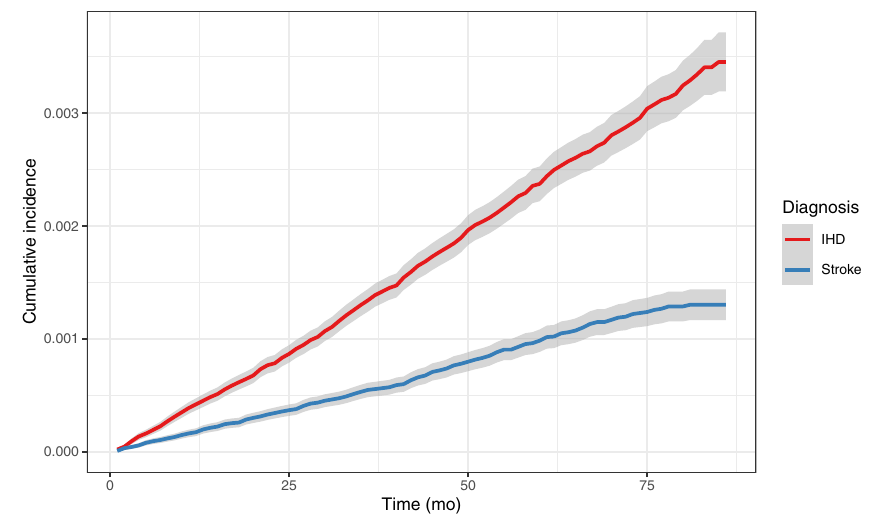
Fig. 2 Cumulative incidence of the outcome IHD: Ischemic heart disease; mo: Months Y-axis (Cumulative incidence) equals to 1 % survival probability. Number of individuals at risk for each diagnosis was shown below the fi gure.